Question: Which kind of chart has been used to present this data?
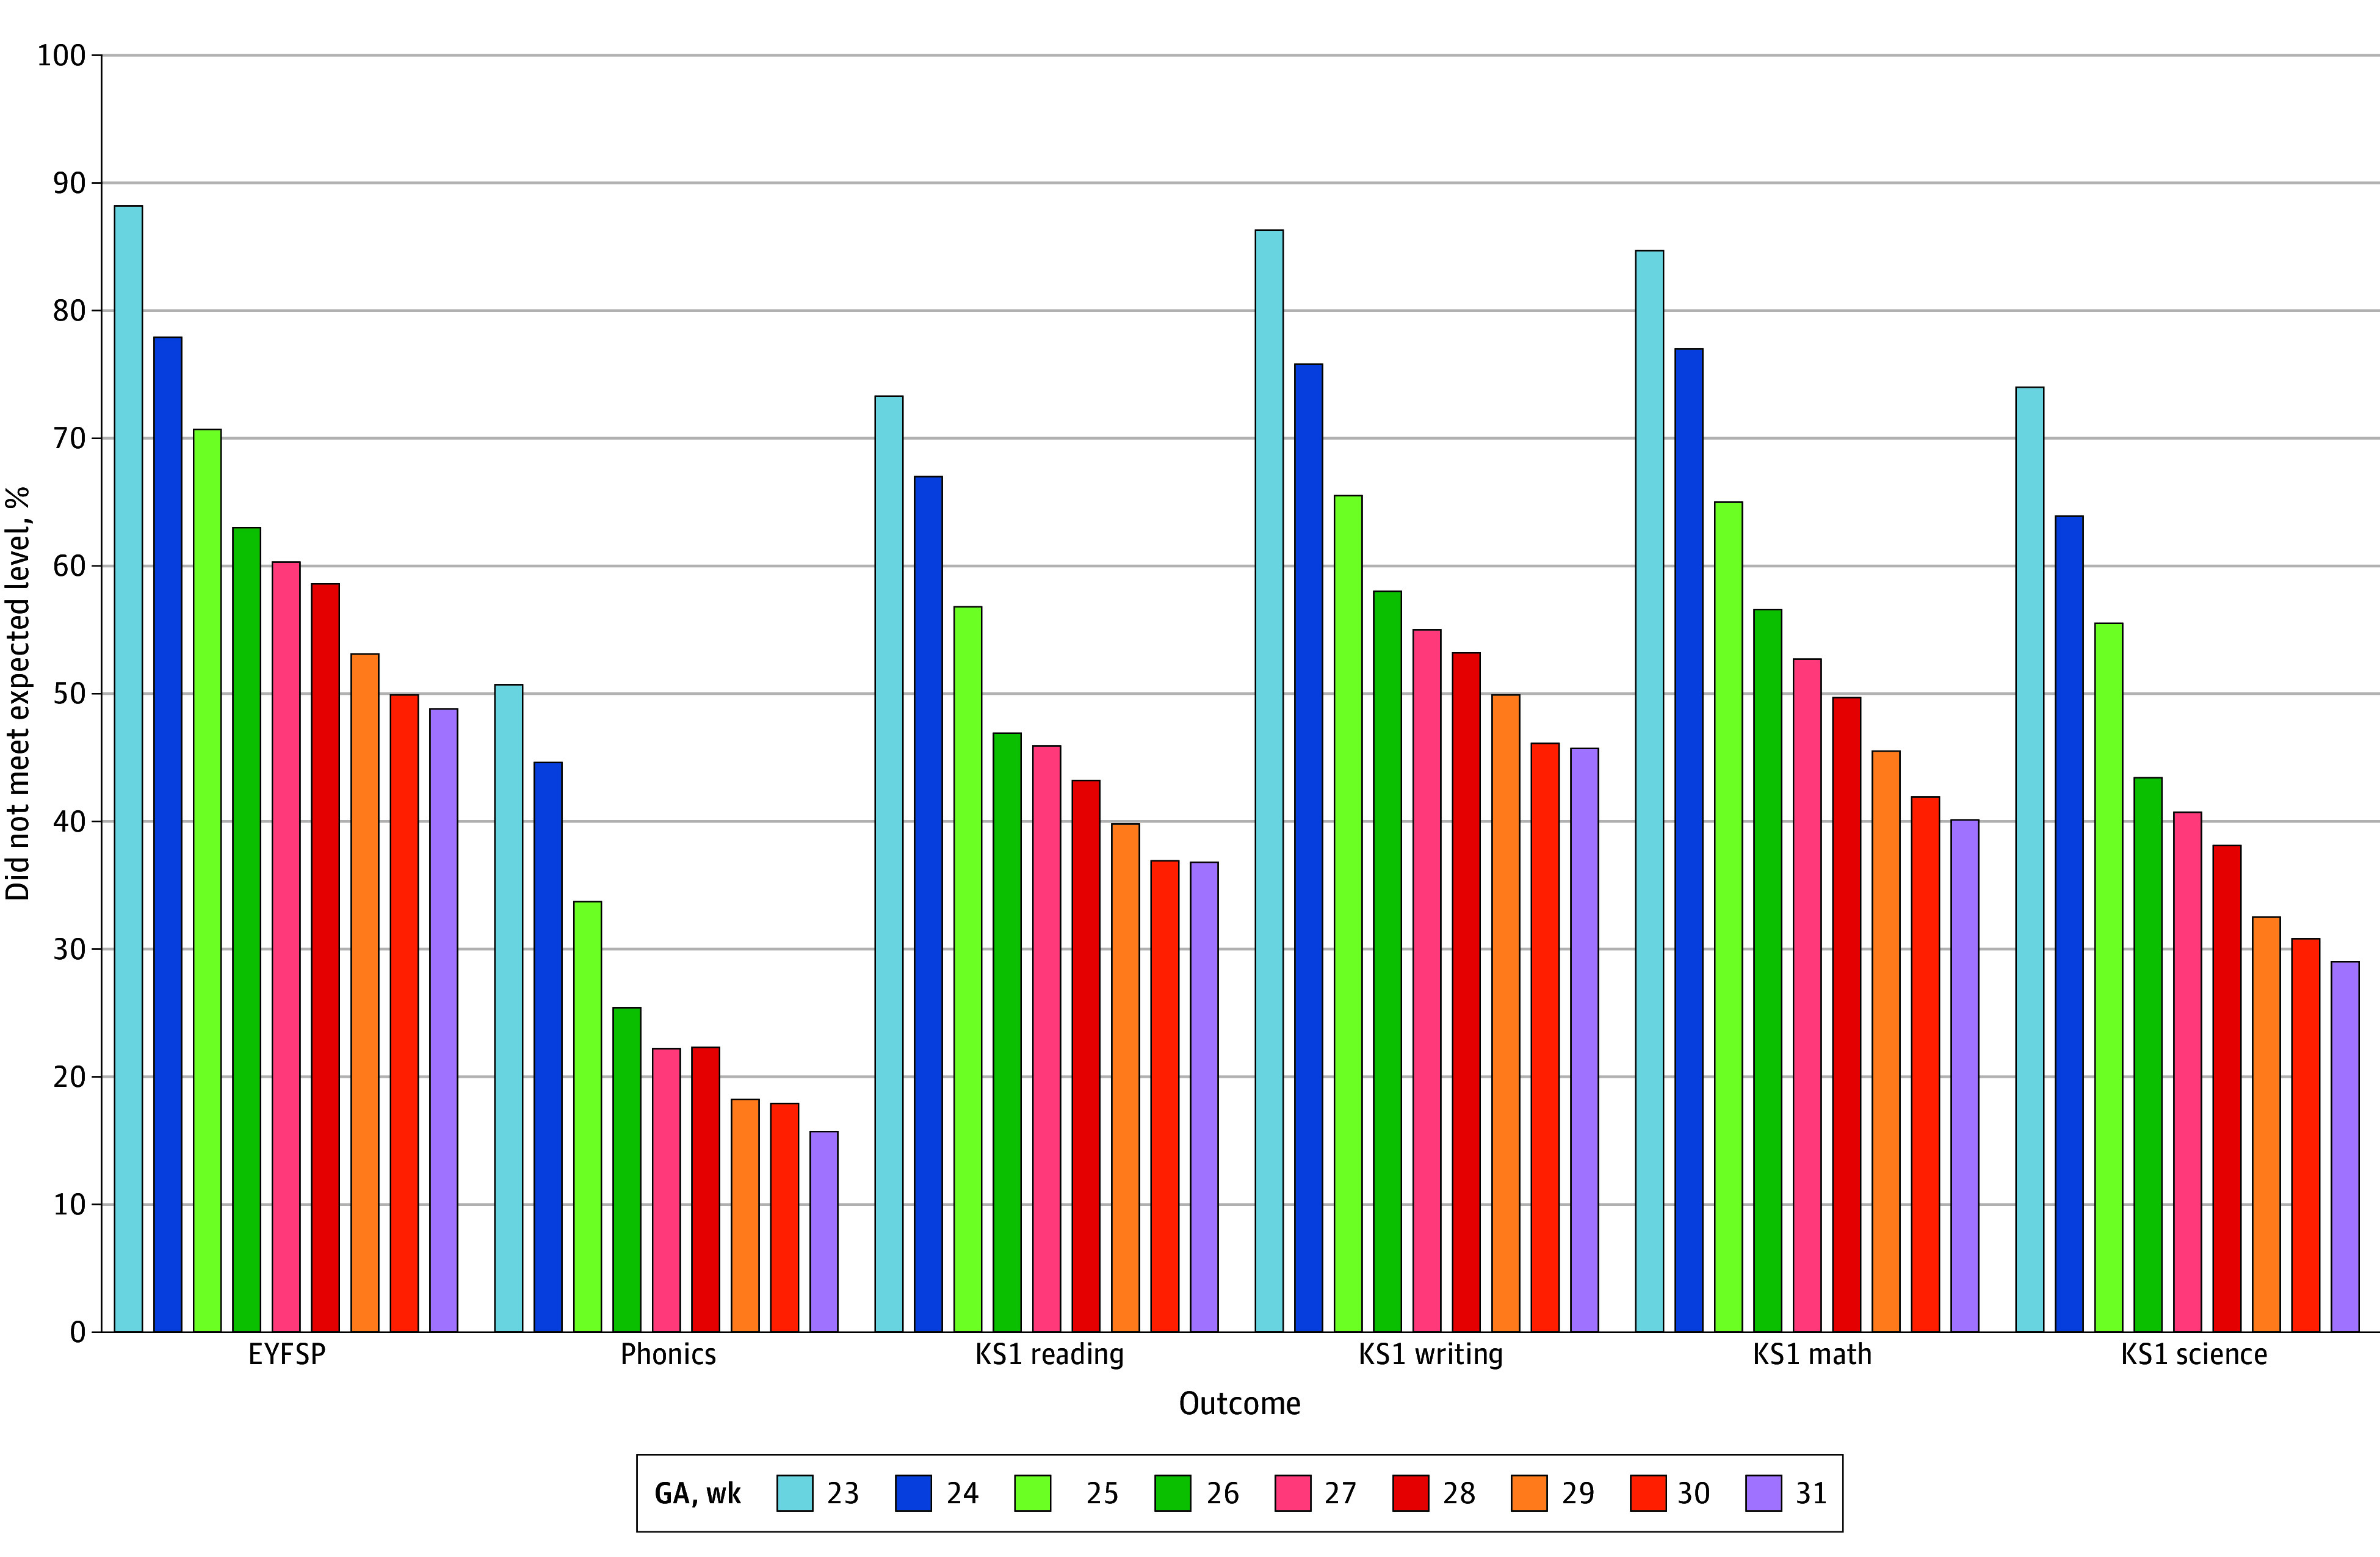
Answer: bar